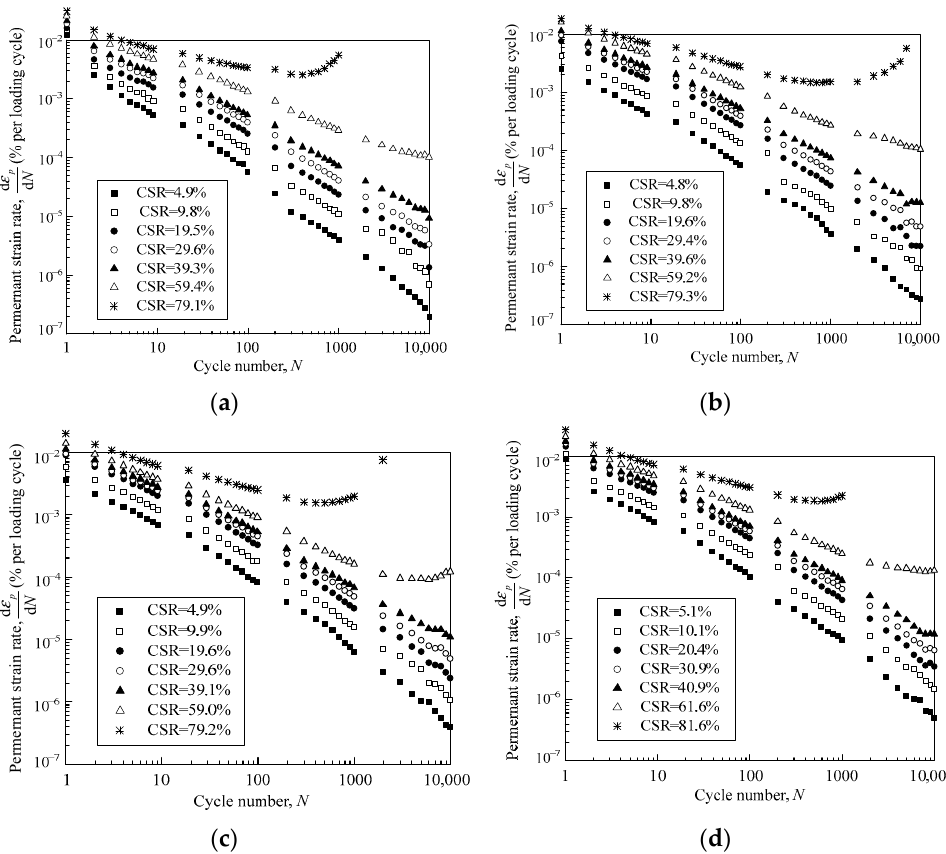
Figure 8. The relationships between strain rate and loading cycles under different CSRs for the tested samples with ( a ) DoC = 0.95, σ 3 = 40 kPa; ( b ) DoC = 0.95, σ 3 = 60 kPa; ( c ) DoC = 1.00, σ 3 = 40 kPa; and ( d ) DoC = 1.00, σ 3 = 60 kPa.